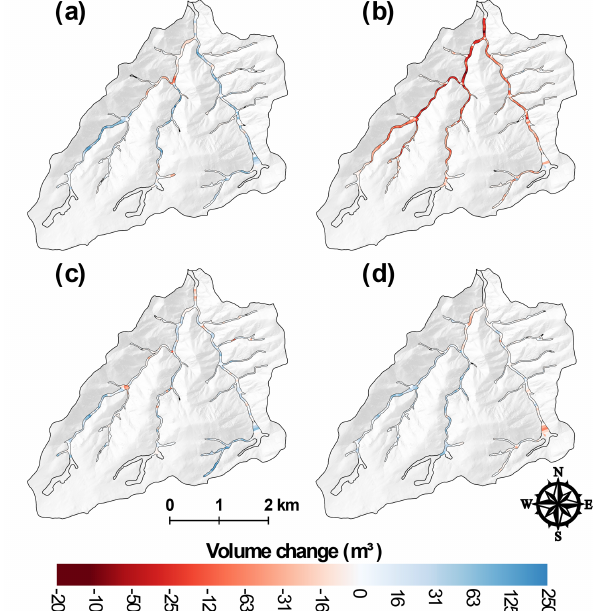
Figure 7. Net volume differences for each valley bottom segment in Hill Gulch for (a) T1 (201210–201307), (b) T2 (201307–201310), (c) T3 (201310–201409), and (d) T4 (201409–201506). Calcu- lated volumes are not reported for the transparent segments in the headwaters and segments furthest downstream (outlined by heavier black lines) due to unrealistically wide valley widths, repeat exca- vations, or the ground surface not being reliably